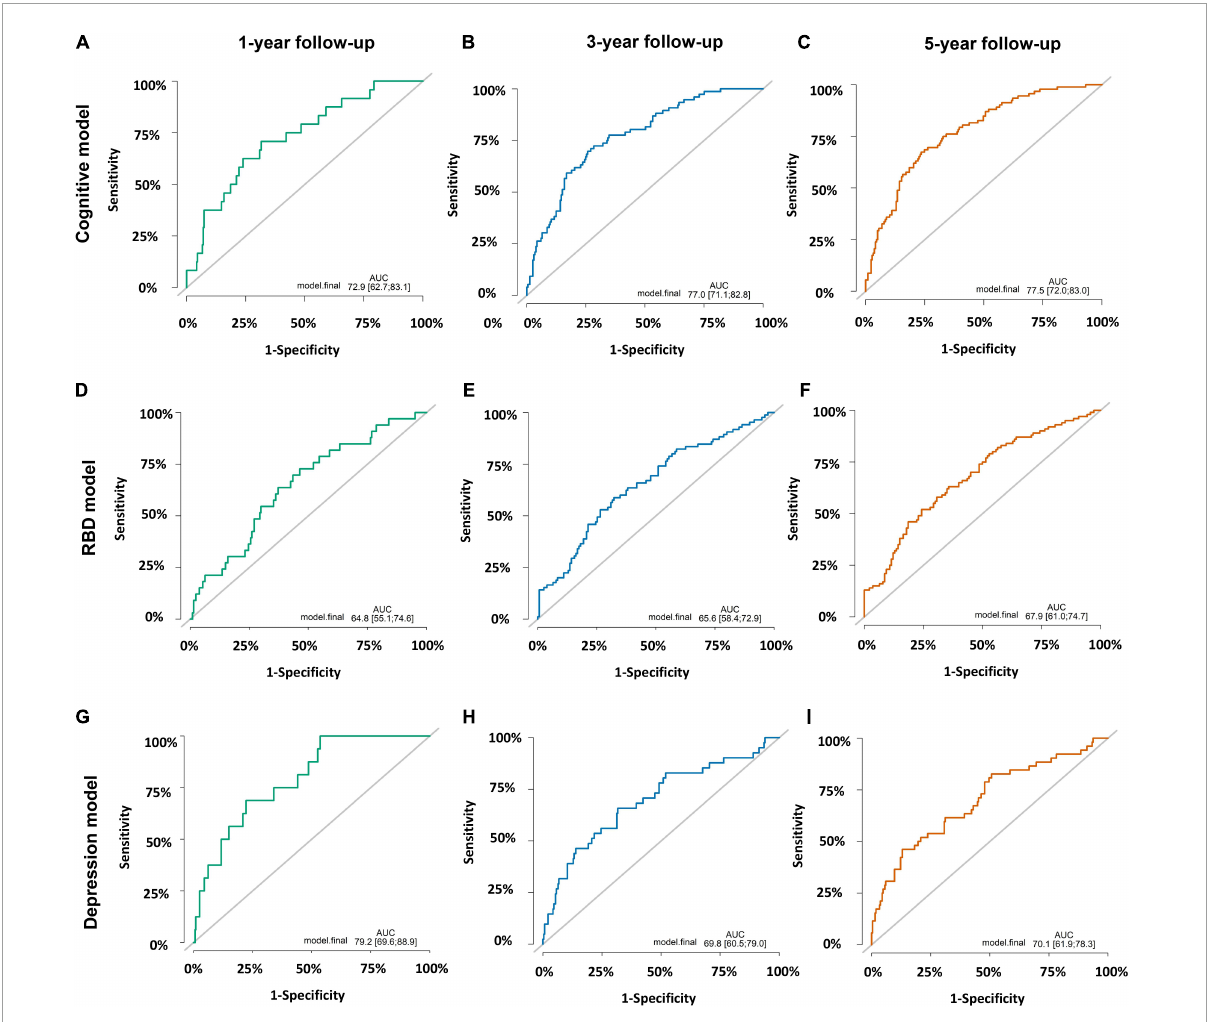
FIGURE4 Prediction accuracies of three prognostic models. (A) Cognitive decline model within 1 year with area under receiver operating characteristic curves (AUC) of 0.73 (95% CI: 0.63–0.83). (B) Cognitive decline model within 3 years with AUC of 0.77 (95% CI: 0.71–0.83). (C) Cognitive decline model within 5 years with AUC of 0.78 (95% CI: 0.72–0.83). (D) Rapid-eye-movement sleep Behavior Disorder (RBD) prognostic model within 1 year with AUC of 0.65 (95% CI: 0.55–0.75). (E) RBD prognostic model within 3 years with AUC of 0.66 (95% CI: 0.58–0.73). (F) RBD prognostic model within 5 years with AUC of 0.68 (95% CI: 0.61–0.75). (G) Depression prognostic model within 1 year with AUC of 0.79 (95% CI: 0.70–0.89). (H) Depression prognostic model within 3 years with AUC of 0.70 (95% CI: 0.61–0.79). (I) Depression prognostic model within 5 years with AUC of 0.70 (95% CI: